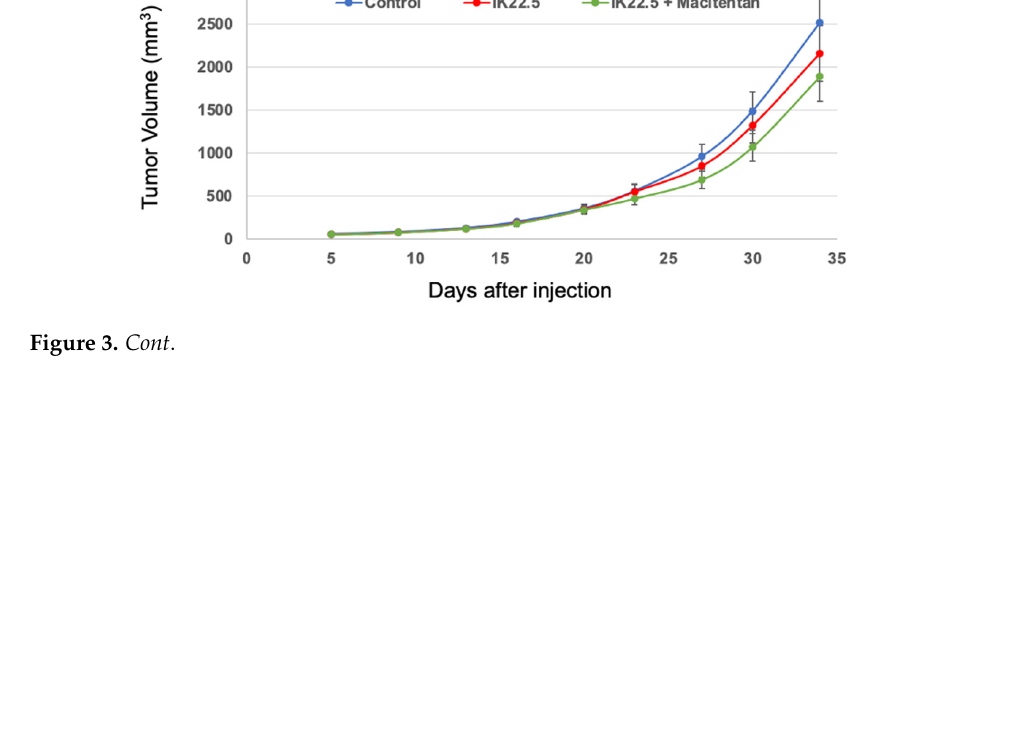
Figure 3. Macitentan (10mg/kg/day) strengthened the bone protective effect of the RANKL blocking antibody (IK22.5) injections in WT mice and reduced tumoral osteoid tissue formation in Rankl -/- mice either injected with MOS-J/PG1 cells. In the aggressive MOS-J/PG1 osteosarcoma model, RANKL inhibition had no significant impact on tumor growth ( A ) but clearly protected the bone from resorption (white arrow-heads in ( B )) and reduced tumoral osteoid tissue formation (white arrows in ( B )). Nevertheless, this treatment induced enlargement in both trabecular bone (red line in ( C )) and cortical bone (red stars in ( C )). Combining macitentan treatment with RANKL inhibition made it possible to reduce this enlargement (blue line in ( C )). The MOS-J/PG1 osteosarcoma model could be applied to Rankl -/- mice (C57BL/6J background) and slightly slower tumor growth was ob- served compared to WT mice ( D ). Macitentan had no impact on tumor growth in Rankl -/- mice ( D ) but a significant reduction in tumoral osteoid tissue formation was observed (arrow in ( E )) com- pared to the untreated Rankl -/- control mice ( E ). R: right tibia without tumor; and L: left tibia with tumor.